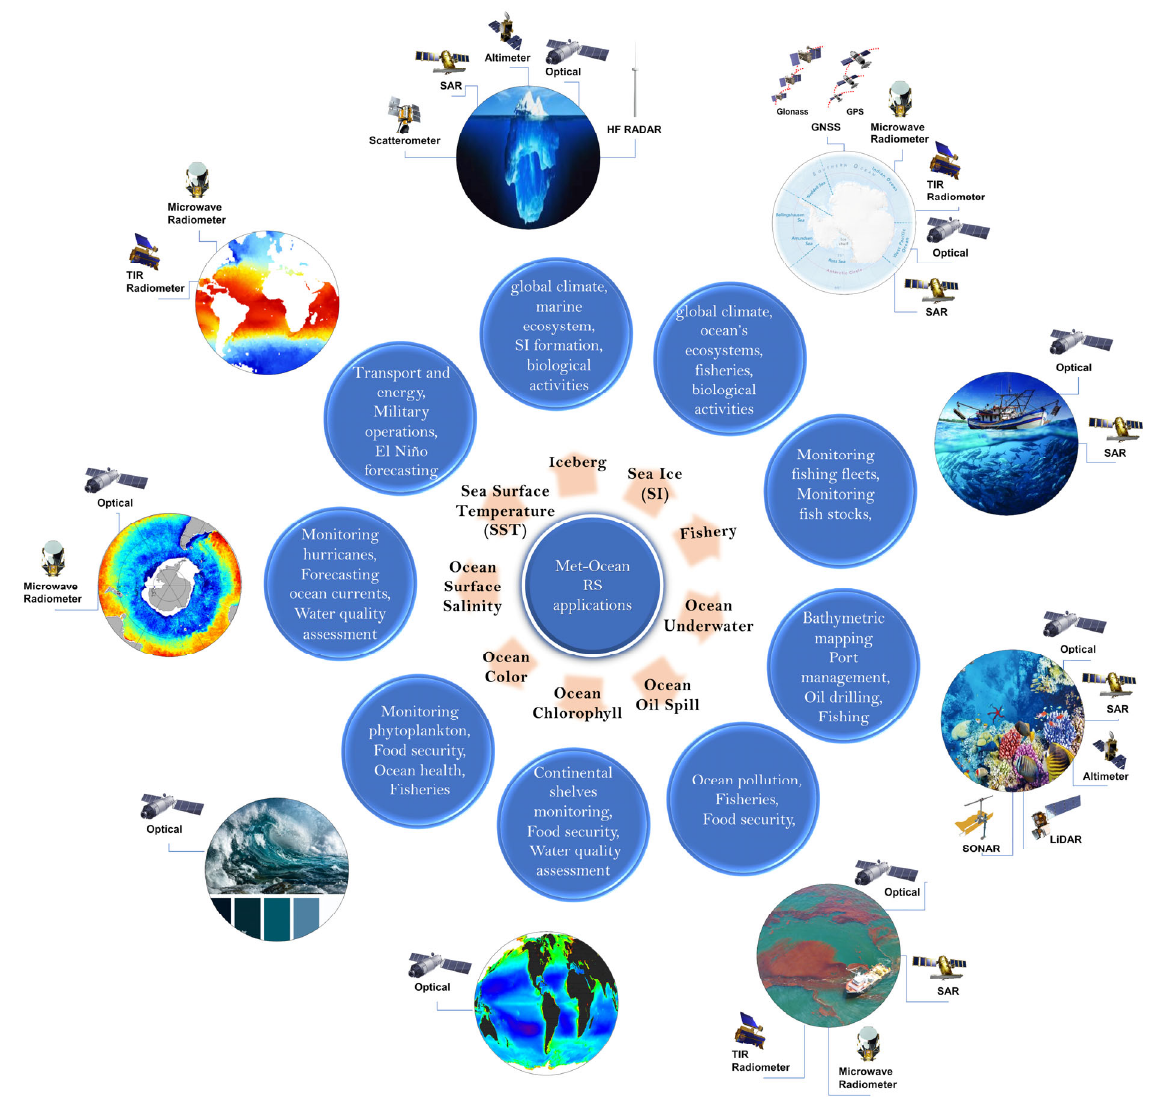
Figure 1. overview of the met ‐ ocean applications of RS, which are discussed in this review paper. Figure 1. Overview of the met-ocean applications of RS, which are discussed in this review